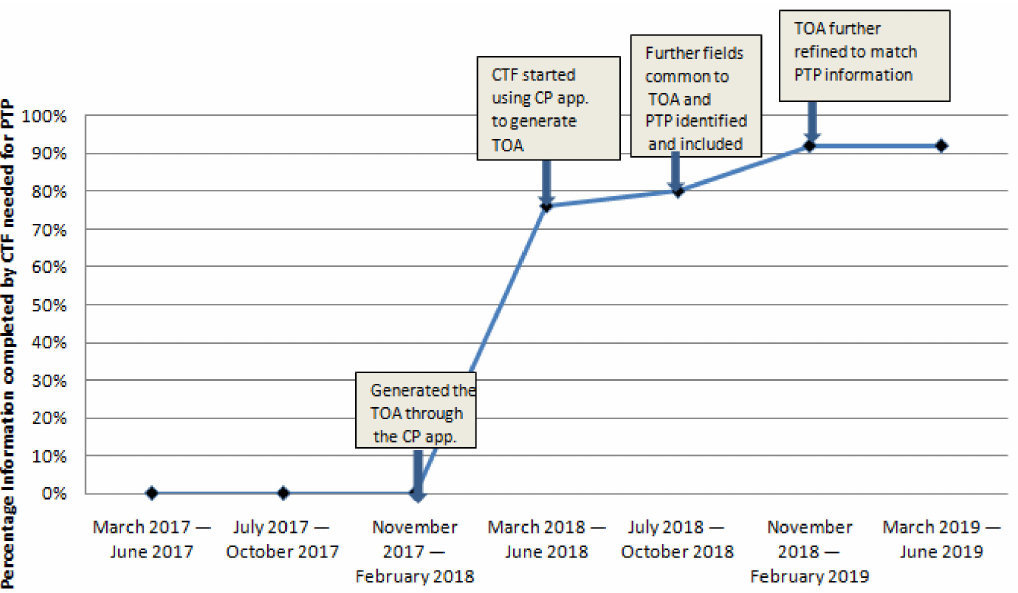
Figure 3. Percentage of information completed by care transfer facilitator forgenerating the PCP. TOA = transfer of accountability document, CTF = care transfer